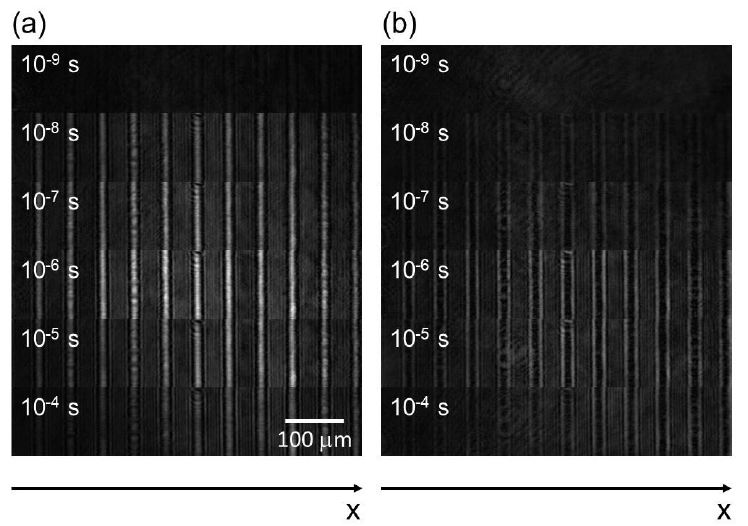
Figure 2. The image sequences of MBBA recorded by the PI-PM method are shown: ( a ) ∆ n e ( t ) and ( b ) ∆ n o ( t ) images were captured when the probe polarization was parallel or perpendicular to the director axis, respectively. The pump intensity was 4.22 mJ/pulse.